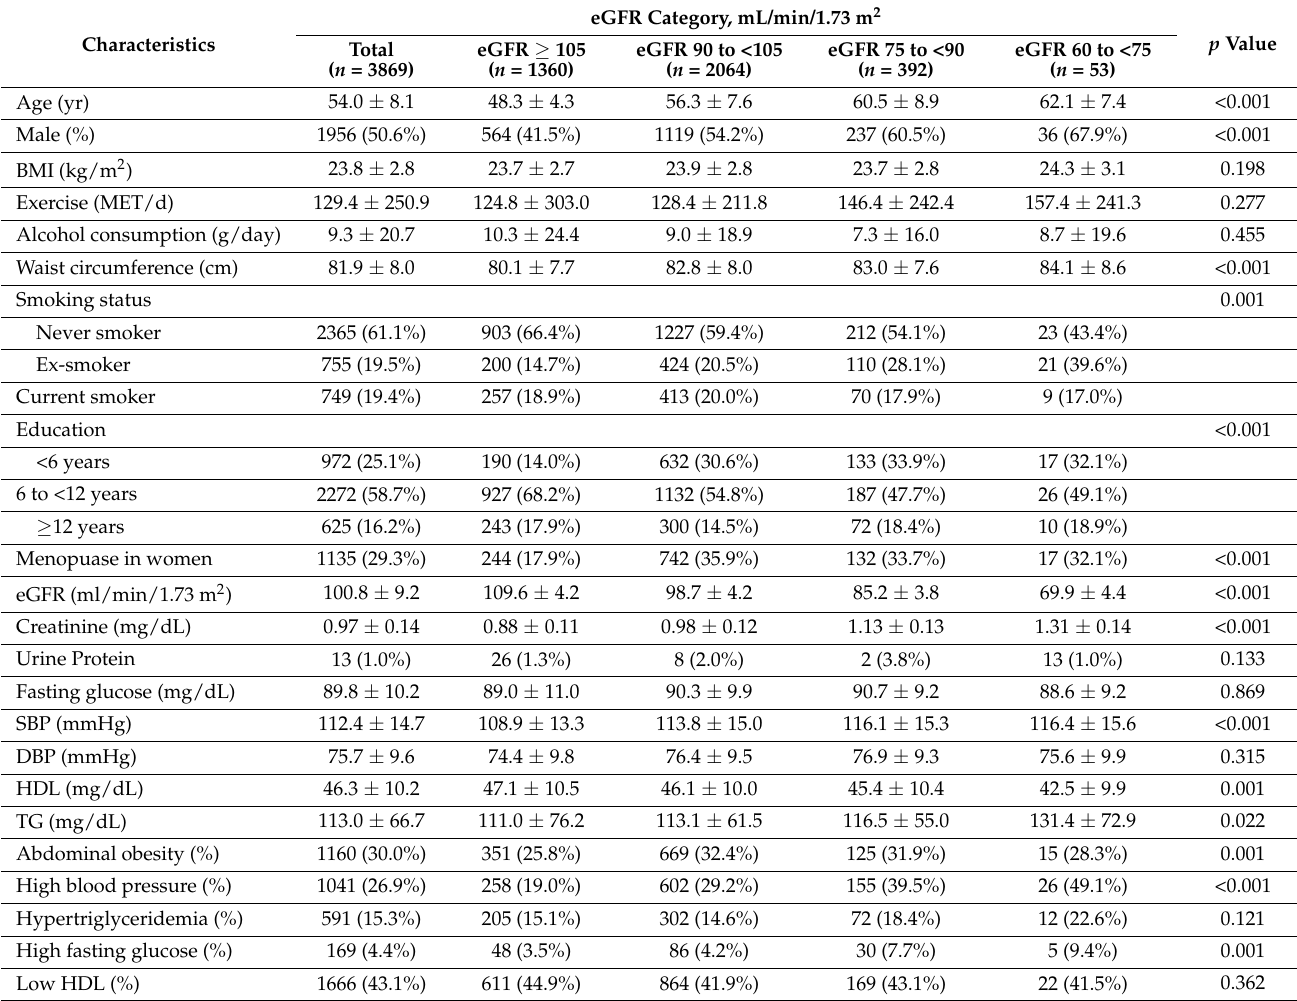
Table 1. Baseline characteristics of the KoGES cohort study participants based on eGFR category ( n =